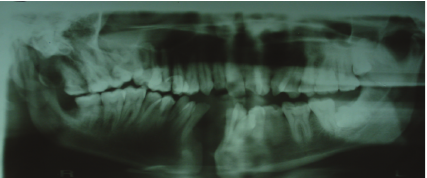
Figure 6: Preoperative orthopantomogram shows mandibular sym- physis cleft.